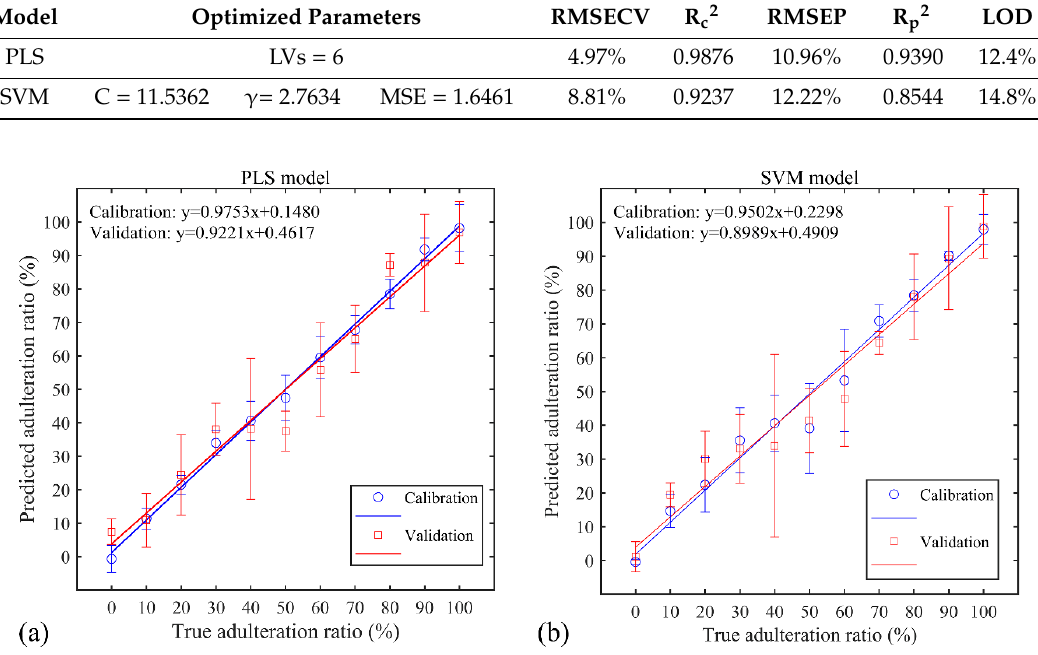
Figure 6. Loading plots of the latent variables as a function of the wavelengths. Table 2. Prediction results of gelatin adulteration by using the PLS model and SVM model, respectively. LOD: limit of detection.